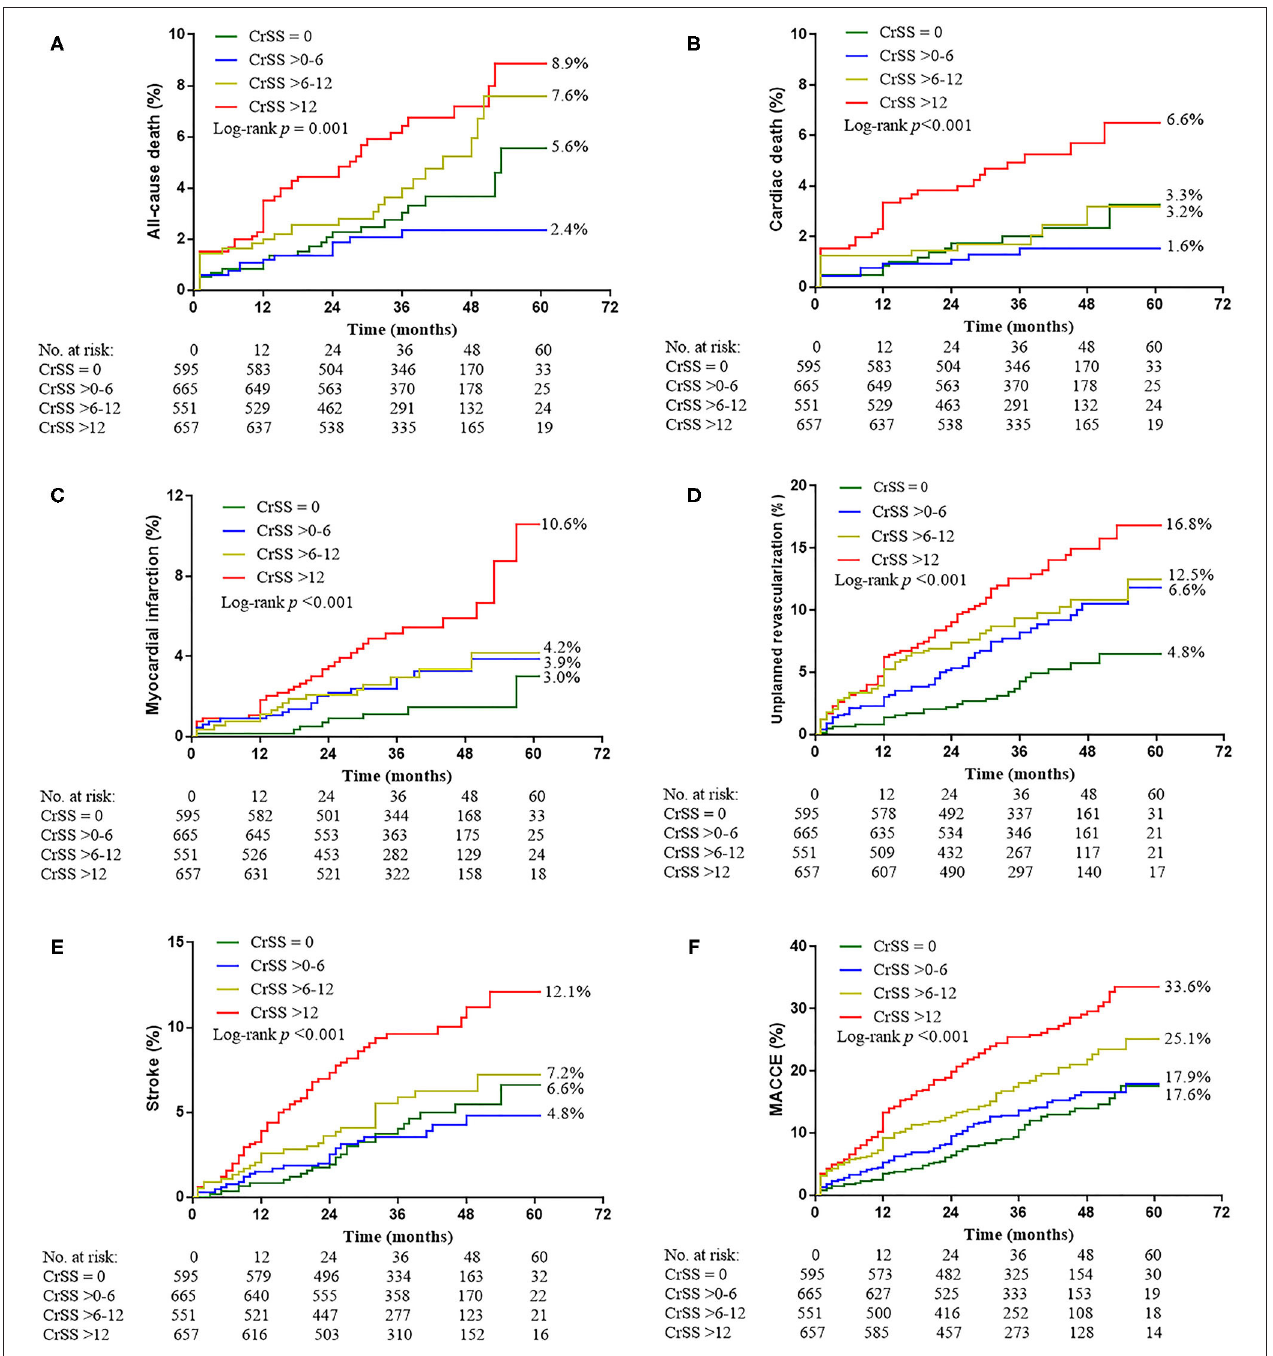
FIGURE 2 | Kaplan-Meier Curves Showing Event Rates Stratified by the CRSS Through 5 Years. (A) All-cause death. (B) Cardiac death. (C) Myocardial infarction. (D) Unplanned revascularization. (E) Stroke. (F) Major adverse cardiovascular and cerebrovascular events (MACCE).